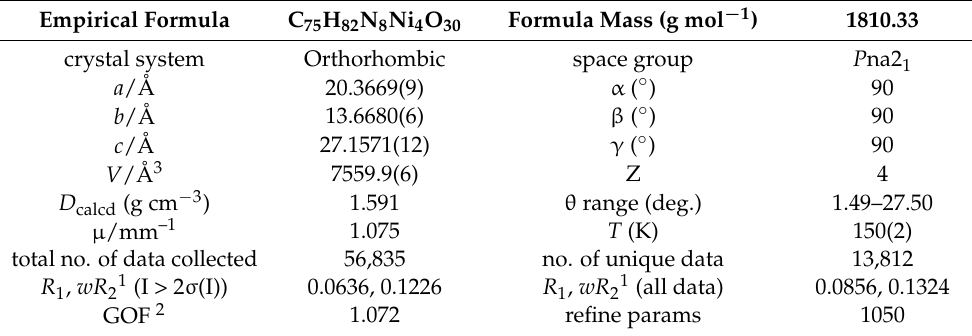
Table 1. Crystal data and refinement details of compound 1